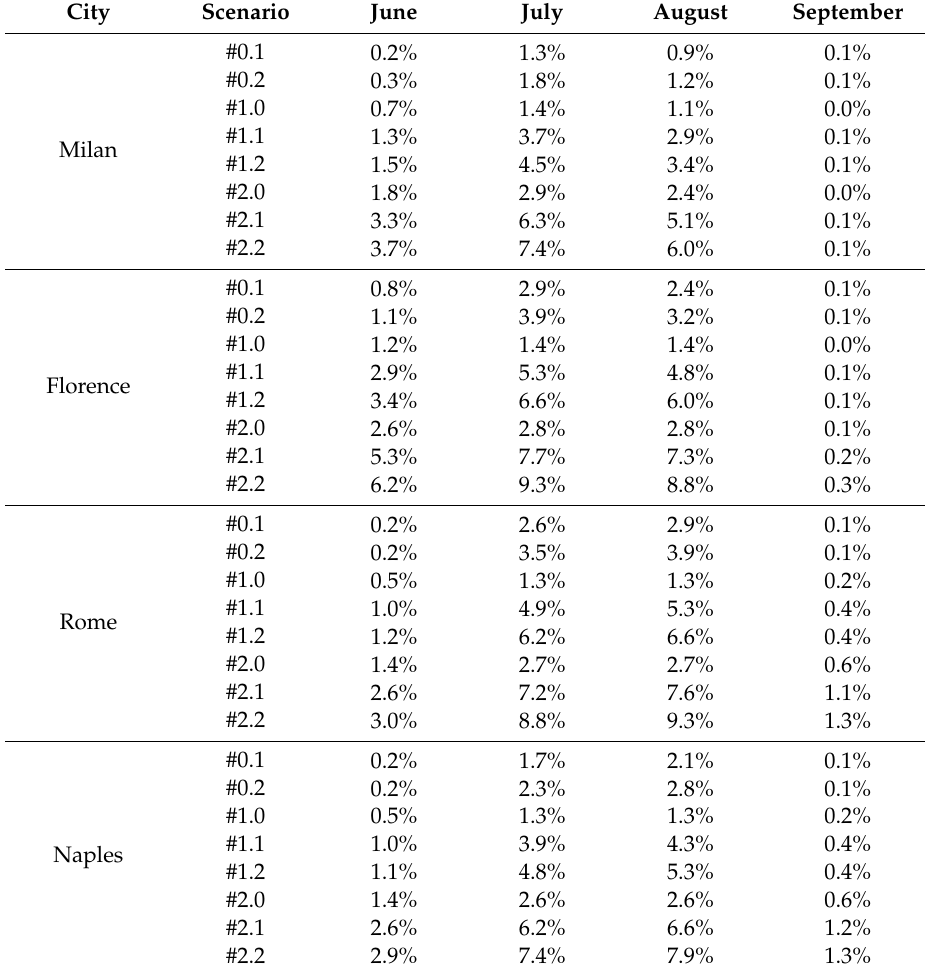
Table 5. Surfaces of photovoltaic systems in percentage compared to the flat surface of single apartment.